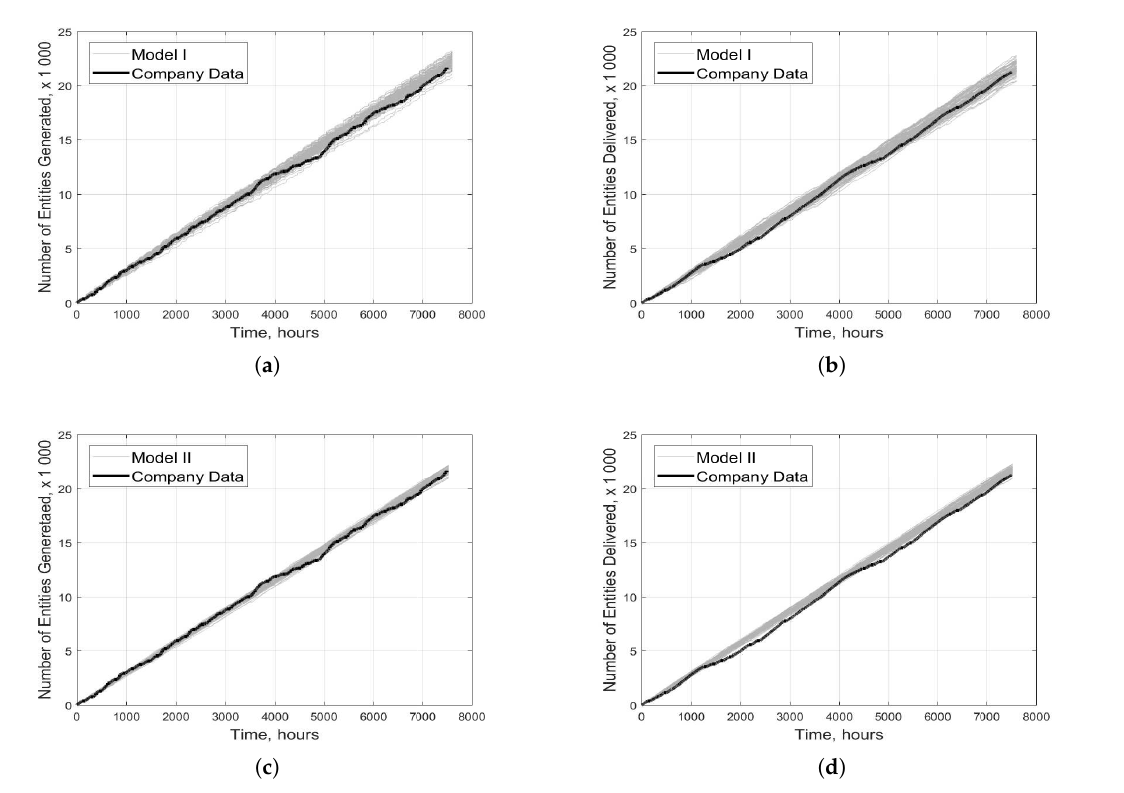
Figure 13. Total numbers of generated and delivered entities based 100 simulation runs representing one year of the log yard’s operations using Model 1 ( a , b ) and Model 2 ( c , d ). Model 1 predicted the generated volume to be 4% higher than the value indicated by the company’s data (877,076 m 3 vs. 844,363 m 3 ), while model 2 predicted it to be 0.1% lower (843,545 m 3